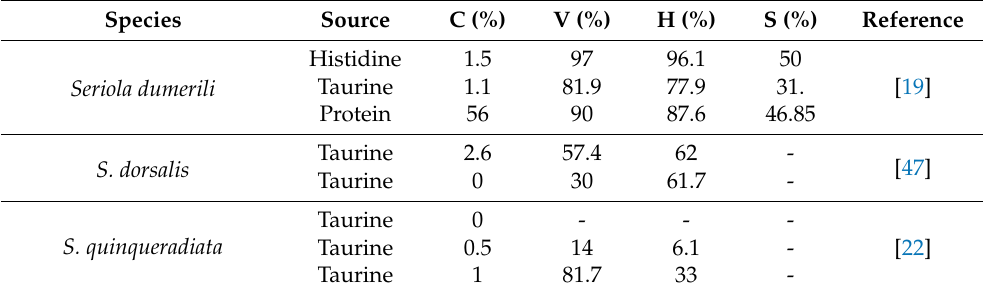
Table 5. Reproductive performance of different species fed different protein sources and concentra- tions. C: Concentration; V: Viable egg; H: Hatching; S: Survival. Species Source C (%) V (%) H (%) S (%) Reference Histidine Seriola dumerili